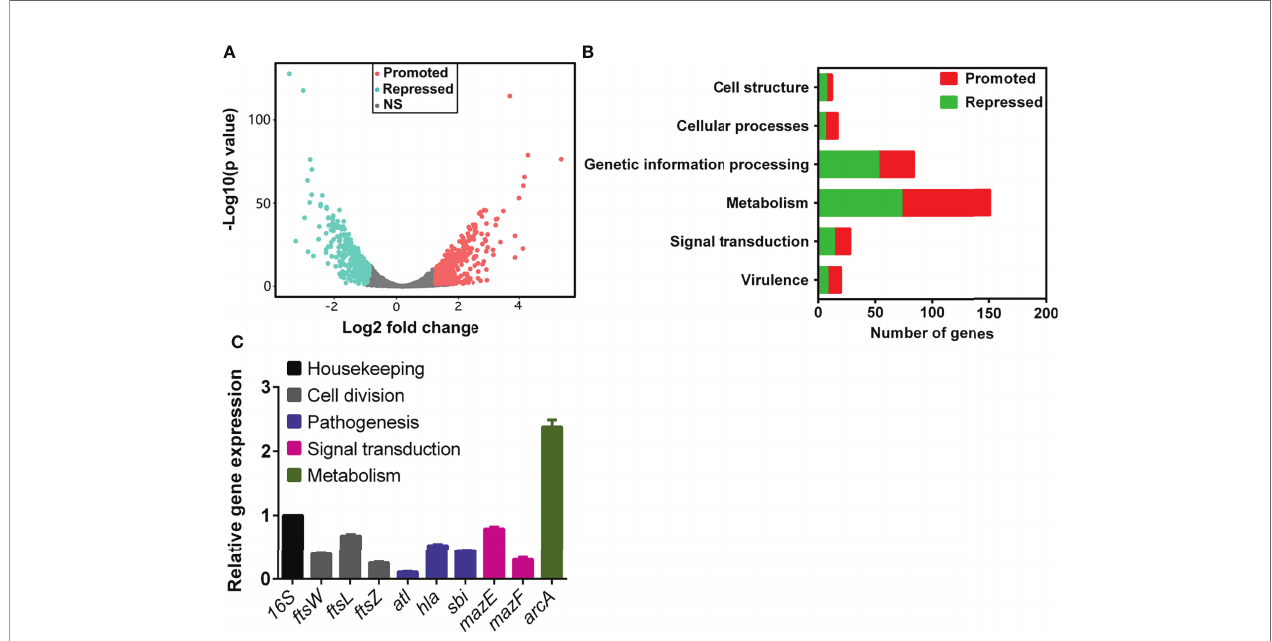
FIGURE 1 | TRQ-treated S. aureus regulon analysis. (A) Volcano plot of differentially expressed genes in TRQ-treated S. aureus cells. NS, not signi fi cant. (B) Functional classi fi cation of differentially expressed genes in TRQ-treated S. aureus . Several major classi fi cations were shown including metabolism and virulence, etc. (C) Relative gene expression analysis of RNA-seq data using qRT-PCR. Statistical analysis was based on pairwise comparisons (Student ’ s t -test). Error bars represent the mean ±